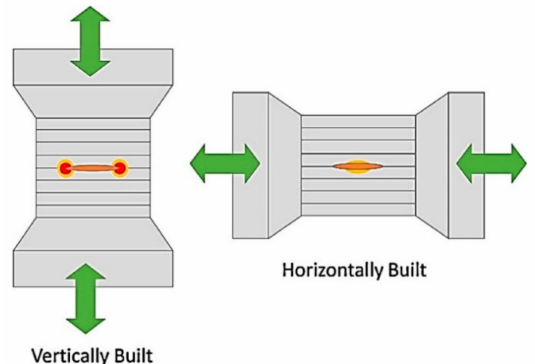
Figure 14. Schematic diagram of the unmelted region formed in the vertical and horizontal building directions with respect to the direction of load and stress concentration